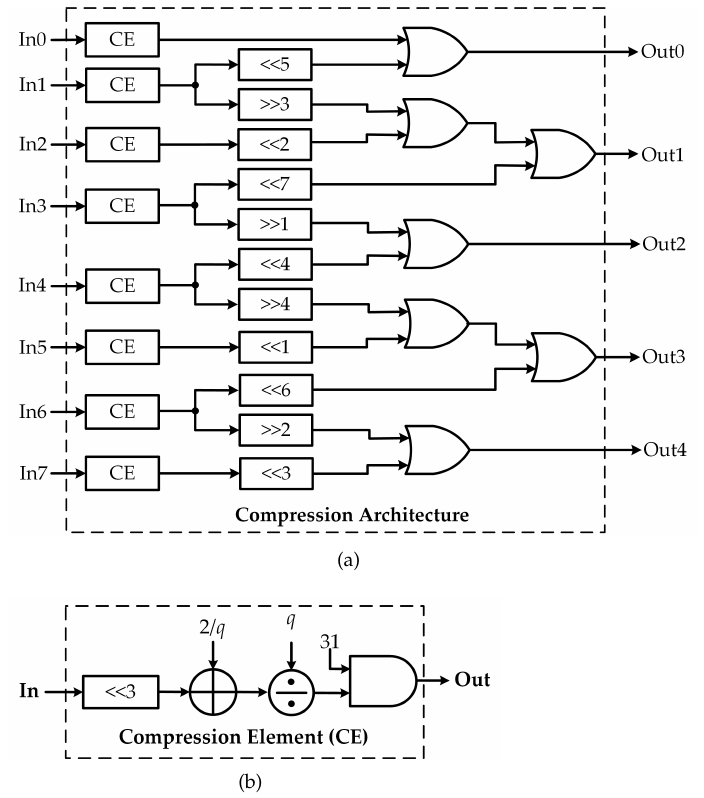
Figure 5. Compression block: ( a ) compression architecture, and ( b ) compression